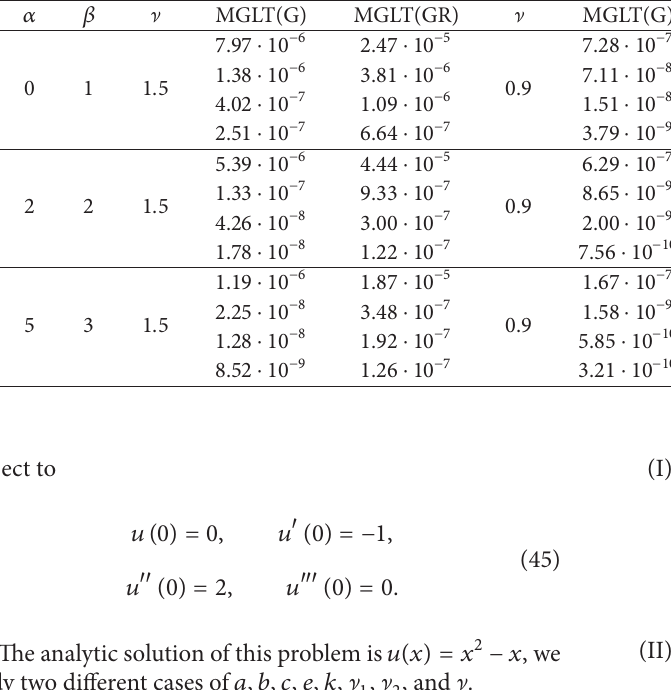
Table 3: Maximum absolute error for 𝛾 = 1/100 , with various choices of 𝑁 , for Example 5 in which 𝑥 ∈ [0,10] .